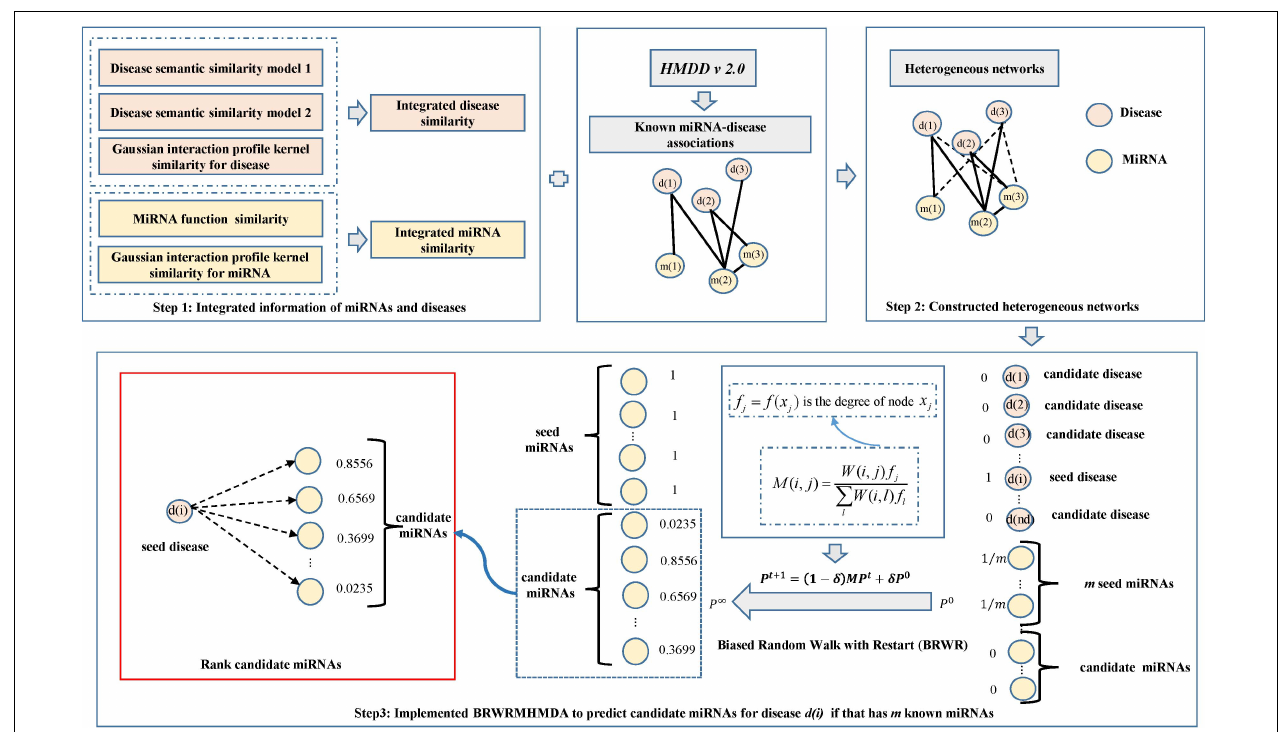
FIGURE 1 | Comparing to the other calculating algorithms (ELLPMDA, IMCMDA, EGBMMDA, MDHGI, TLHNMDA, MaxFlow, RLSMDA, HDMP, WBSMDA, MirAI, and MIDP) in terms of AUCs, BRWRMHMDA gained a better AUC value of 0.8310. It indicates that the proposed model is more suitable for the miRNA–disease association